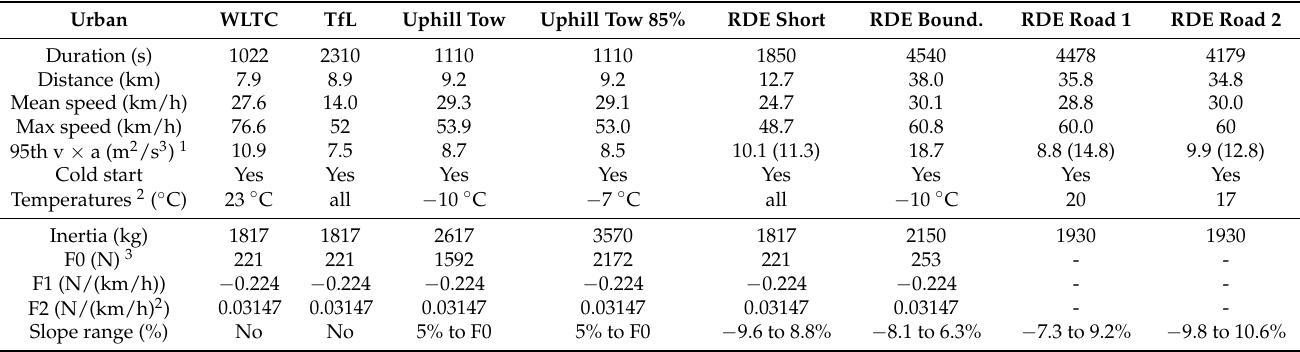
Table A2. Characteristics of the urban cycles (TfL, uphill) and the urban parts of the RDE tests and the WLTC (low and medium phases).